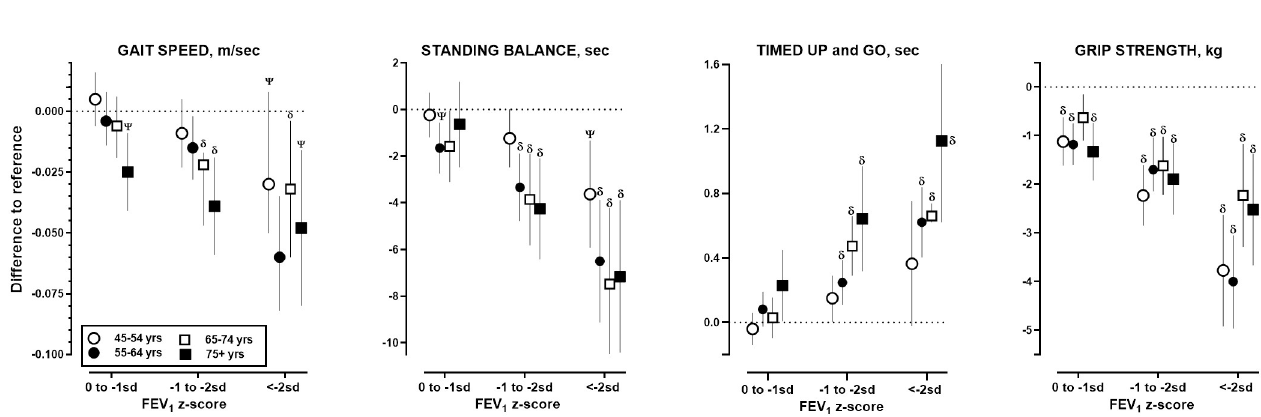
Fig 4. Associations between physical performances with grades of FEV 1 stratified by smoking history. FEV 1 , forced expiratory volume in 1 second; SD, standard deviation.